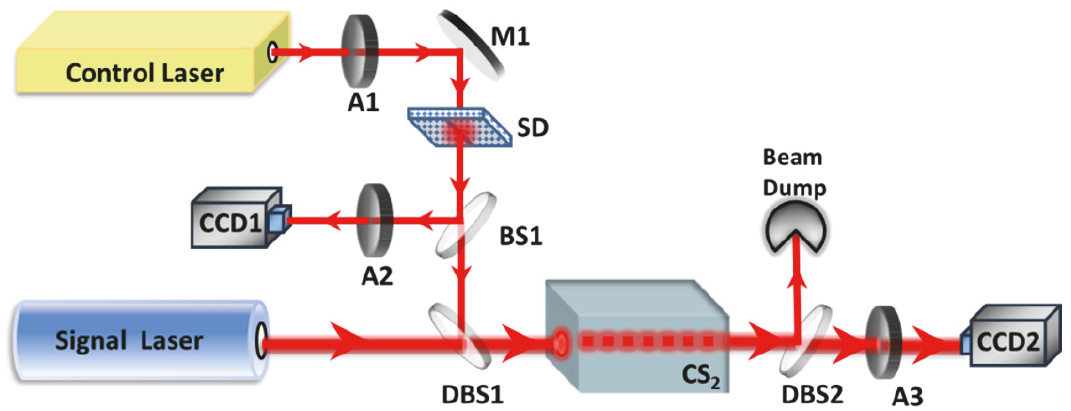
Figure 4: Experimental setup. A1-A3, attenuators; M1, silver-coated plane mirror; SD, beam shaping device; BS1, beam splitter; DBS1 and DBS2, dichroic beam